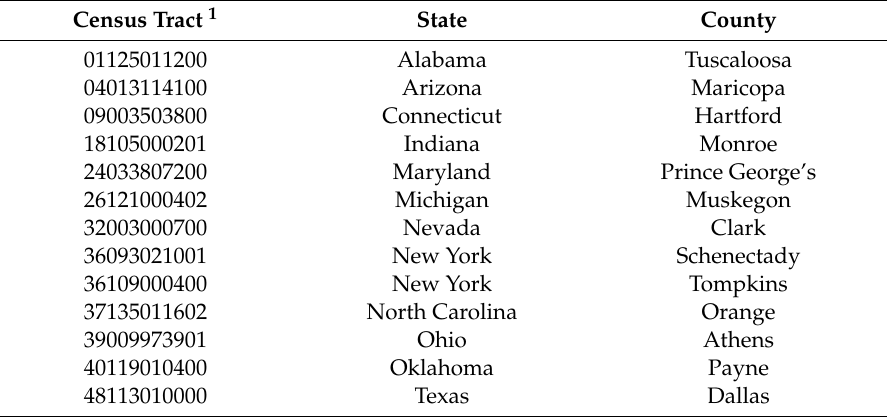
Table 4. A group of low-income low-access census tracts in the Food Access Research Atlas.